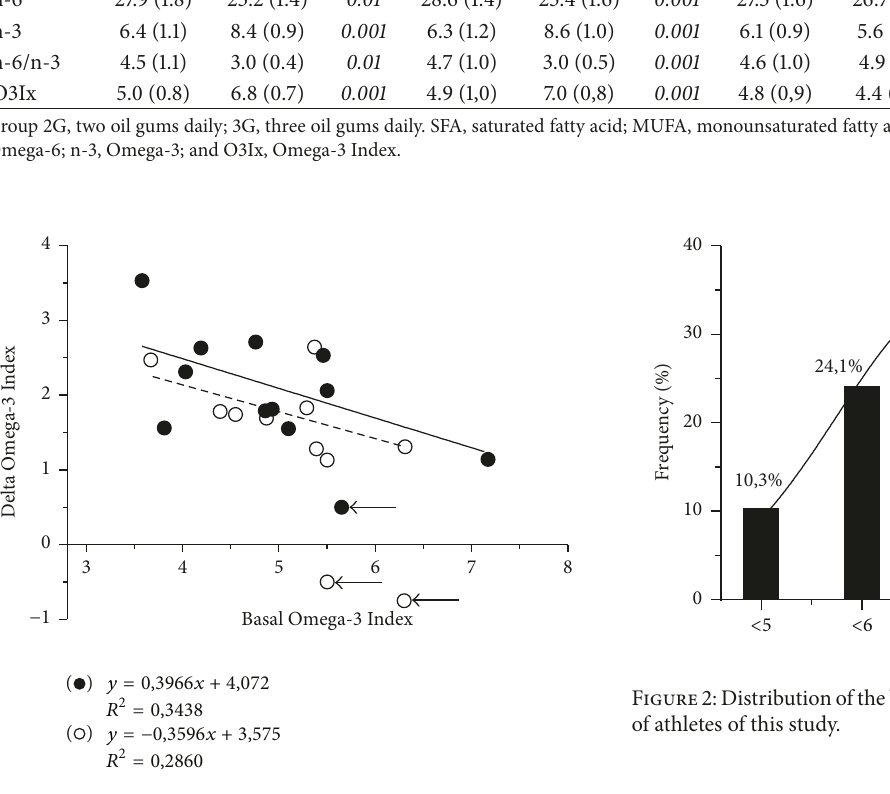
Figure 1: Changes on Omega-3 Index in athletes after 4 months of supplementation infunction ofthedose:( I )group 2G, twooil gums daily; ( e ) group 3G, three oil gums daily. The arrows show those subjects that were unable to comply with the treatment. These data were not added to the statistical evaluation; it is only to show the place in this figure. The line of tendency reflects the delta change of all subjects depending on the basal level and different doses.